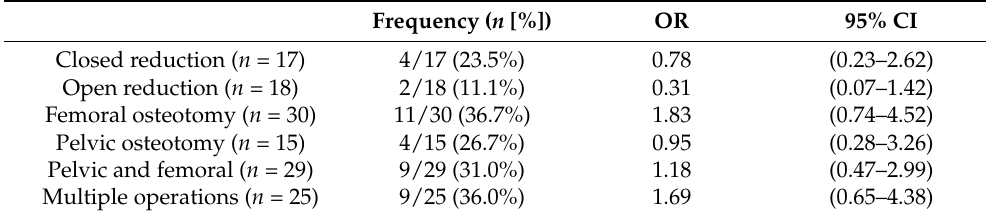
Table 4. The risk of the leg length corrective intervention stratified for the treatment